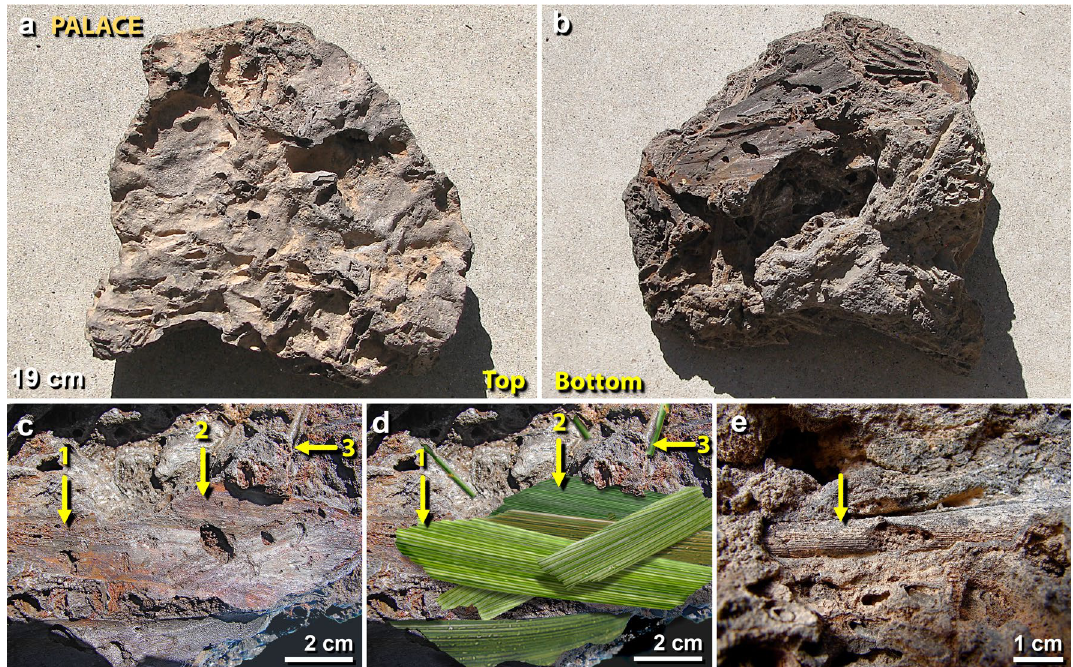
Figure 14. Plant imprints in melted roofing clay from the palace. ( a ) The upper surface of a 19-cm-wide piece of roofing clay, melted and distorted at high temperatures; ( b ) lower surface of the same object, showing imprints of silicified plant material; ( c ) closeup of the lower surface with numbered yellow arrows pointing to ribbed imprints of leaves pressed into the bottom of roofing clay (#1 through #3); ( d ) artist’s depiction, re-creating possible leaf structures before combustion; ( e ) yellow arrow points not to a plant imprint, but rather to a cylinder-like silica-rich pyromorph of plant stem embedded in roofing clay. From the destruction layer in the palace (Field UA, Square